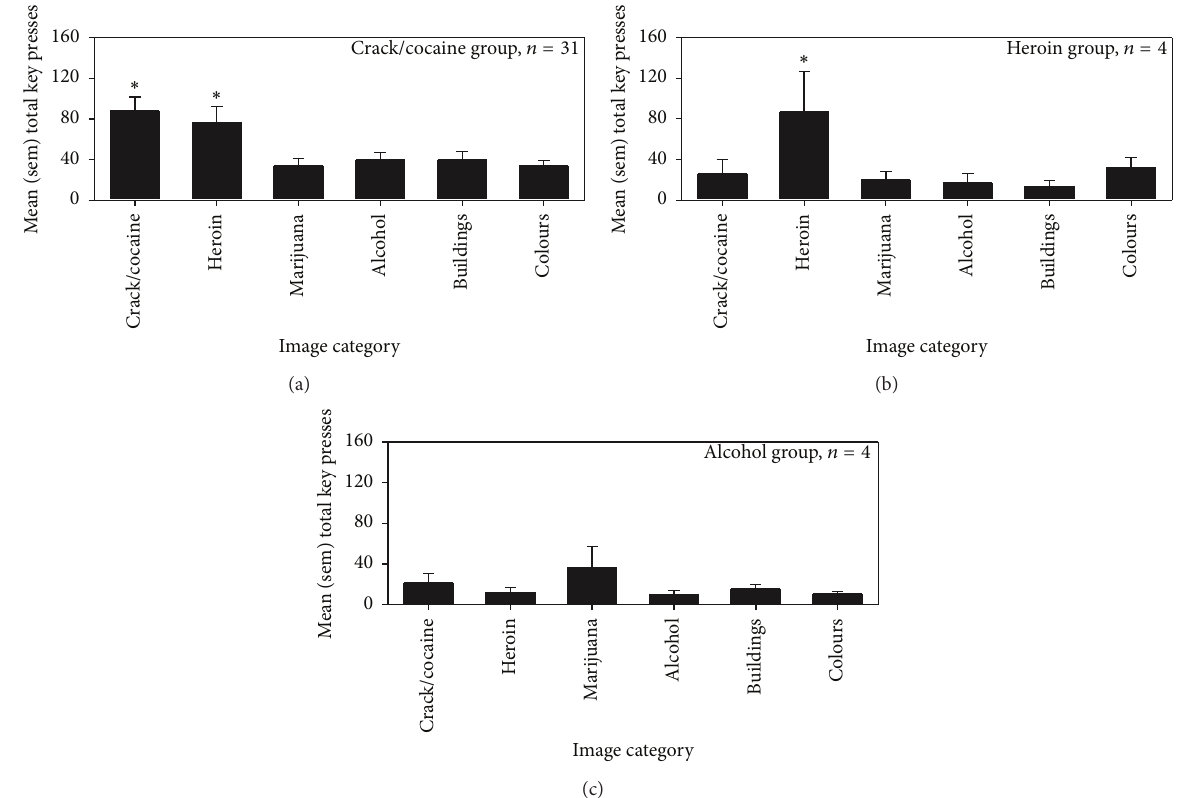
Figure 2: CRT performance in volunteers tested at Stonehenge Therapeutic Community. Mean and sem total number of responses made on computer keys by groups created on the basis of drug of choice ((a) = crack/cocaine, 𝑛 = 31 ; (b) = heroin, 𝑛 = 4 ; and (c) = alcohol, 𝑛 = 4 ). A progressive ratio schedule of reinforcement controlled the relationship between responses on the keys and a 1sec activation of pictures. Four different keys generated images of cocaine/crack, heroin, marijuana, or alcohol look-alike substances use, and paraphernalia. Two additional keys generated control images of buildings and random colors. The ∗ indicates a significant difference, within group, between responding a specific key and all other keys. In (a) responses to the crack/cocaine and heroin keys were not significantly different from each other.